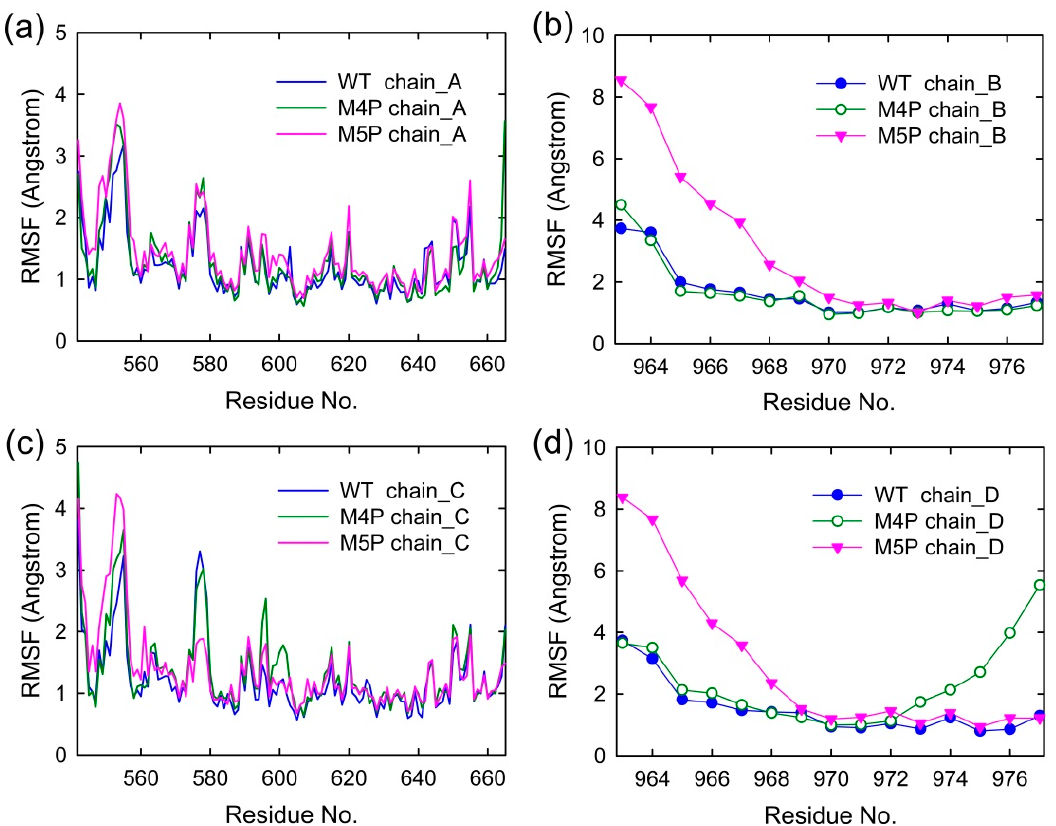
Figure 3. Per residue RMSF of four chains in WT, M4P and M5P systems. ( a ) RMSF of N-PDZ (chain A); ( b ) RMSF of E-PBM (chain B); ( c ) RMSF of N-PDZ (chain C); ( d ) RMSF of E-PBM (chain D).